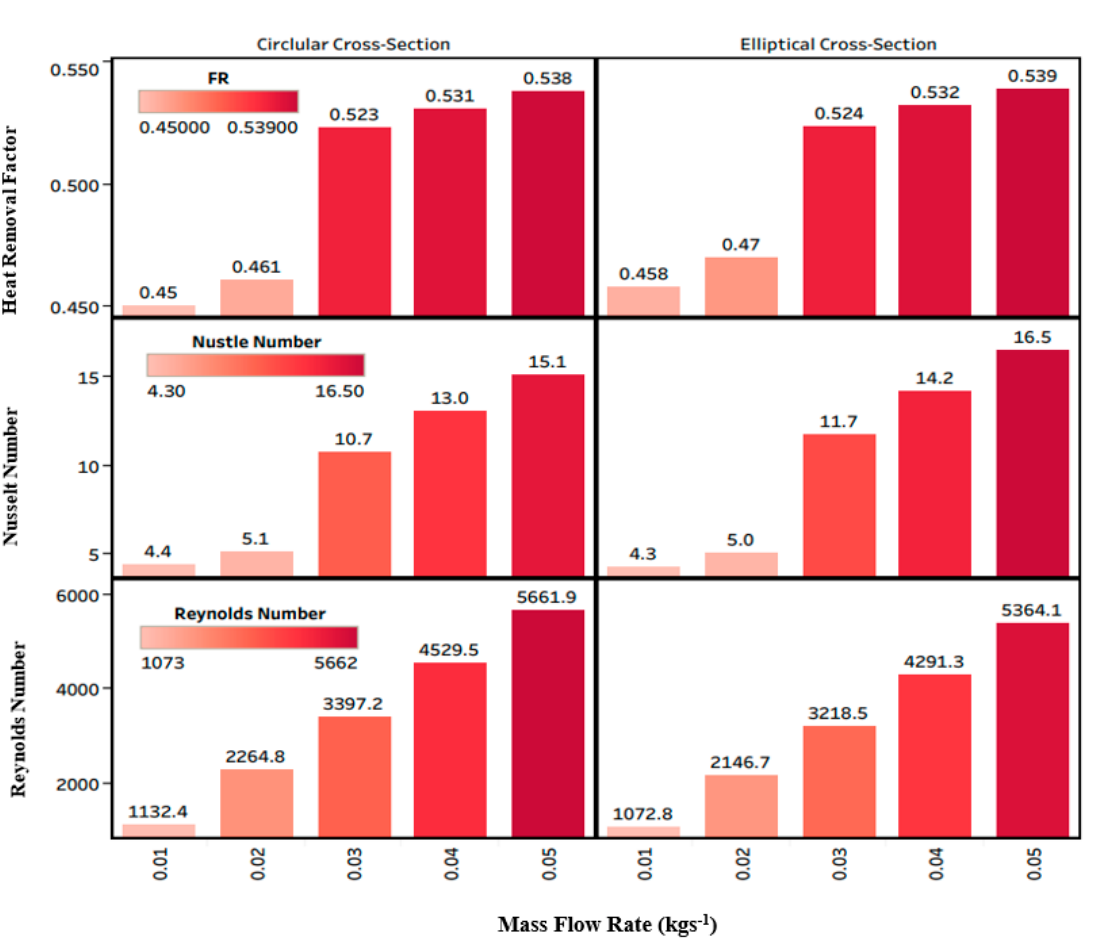
Figure 7. Effects of 𝑚(cid:4662) on the 𝑅𝑒 , 𝑁𝑢 , and 𝐹 (cid:3019) .